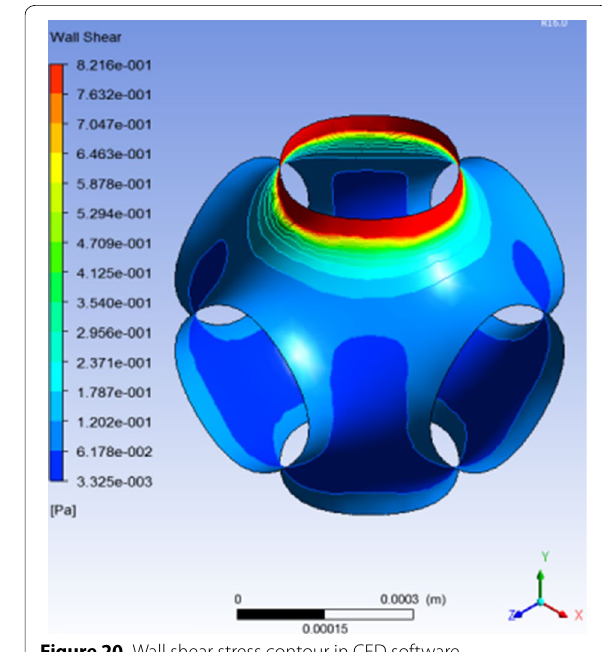
Figure 20 Wall shear stress contour in CFD software